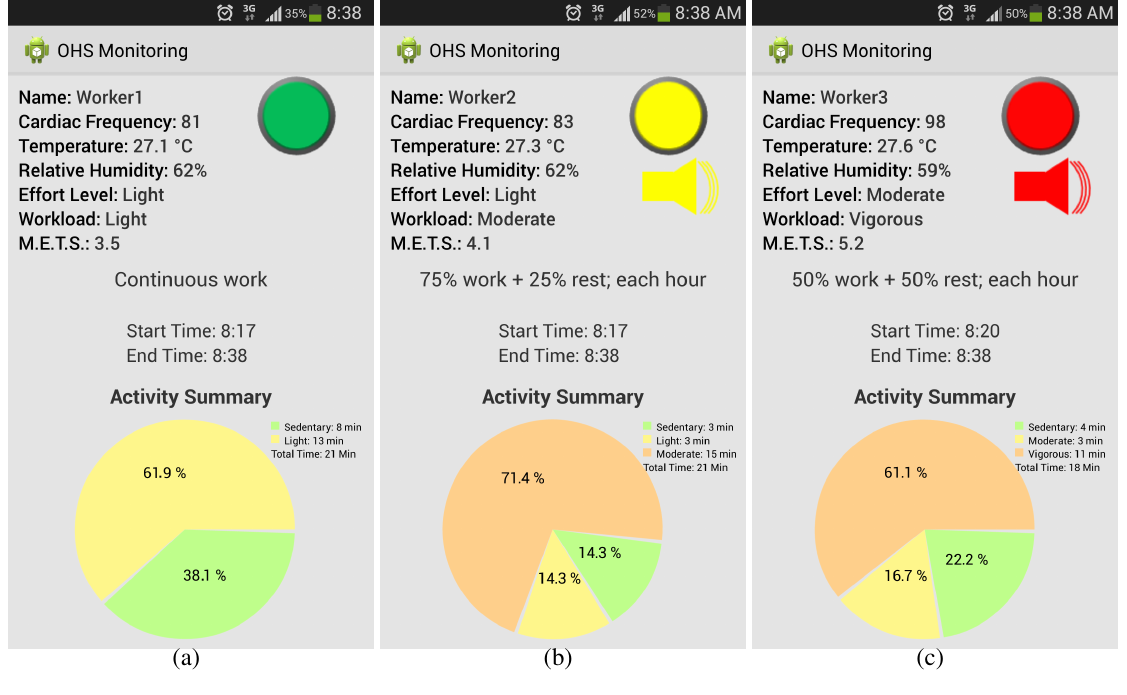
Figure 7. Different OHS levels during morning monitoring: ( a ) without OHS; ( b ) warning alarm previous to OHS; and ( c ) alarm for OHS.